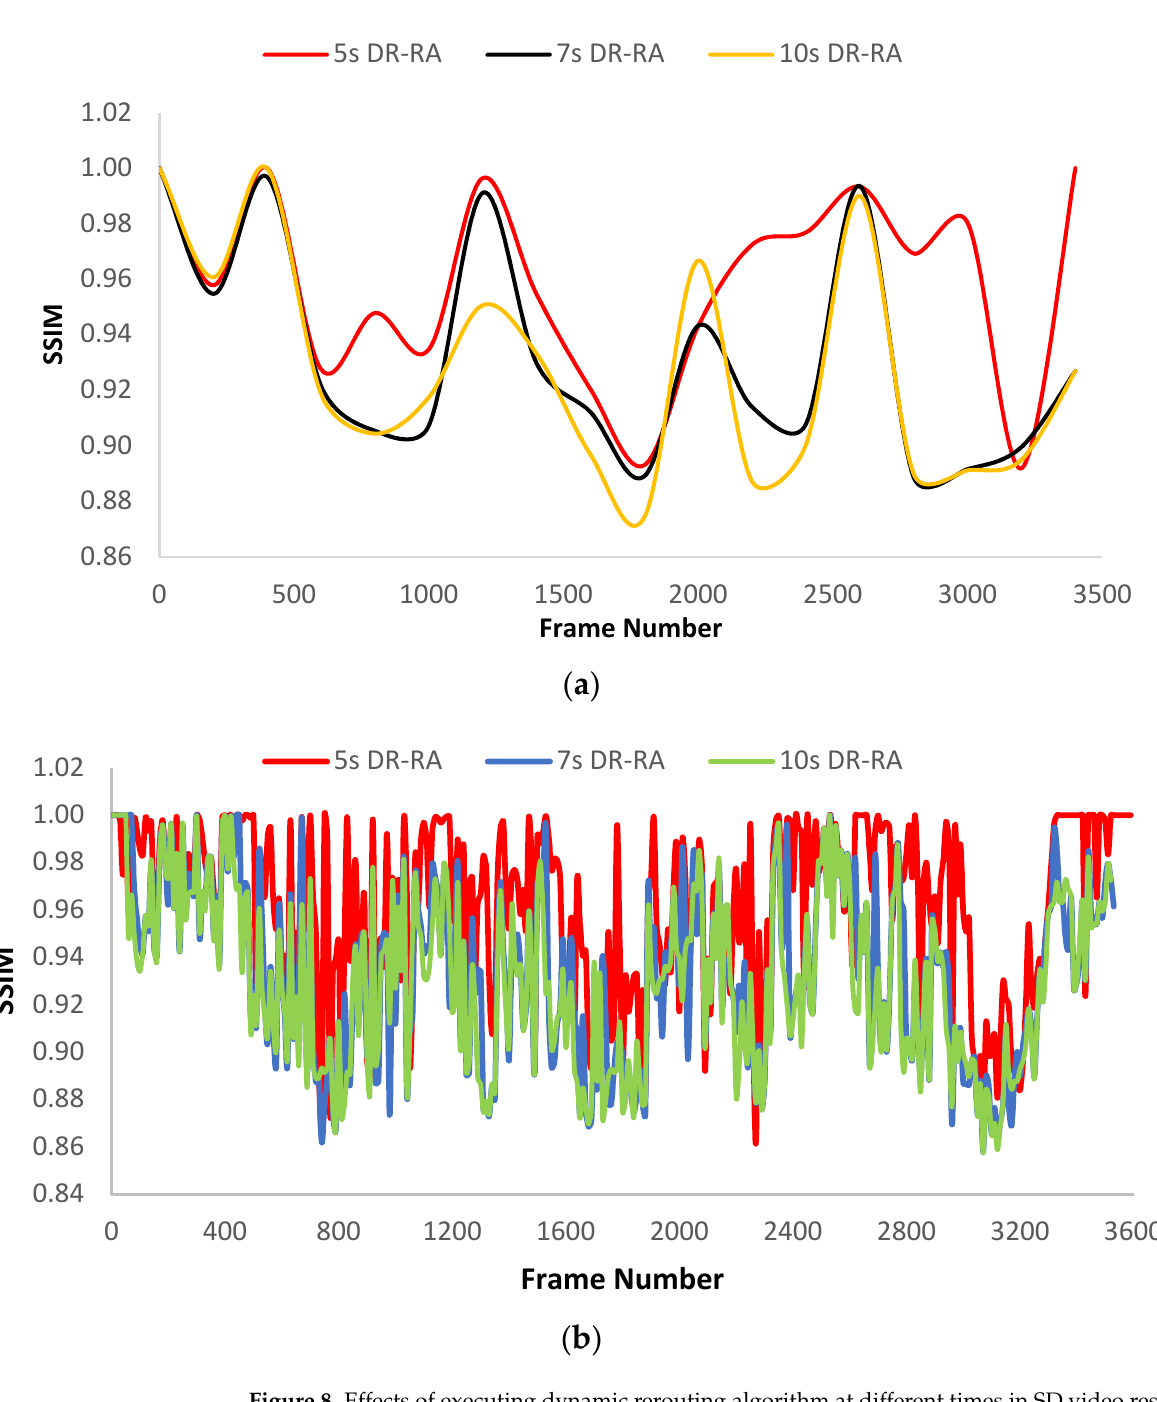
Figure 8. Effects of executing dynamic rerouting algorithm at different times in SD video resolution. ( a ) SSIM values are measured every 10 frames; ( b ) SSIM values are measured every 200 frames.